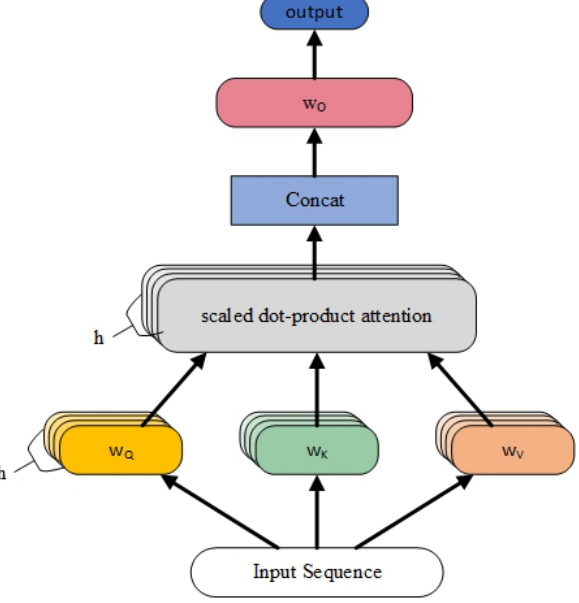
Figure 4. Schematic of Multi-Head Attention.